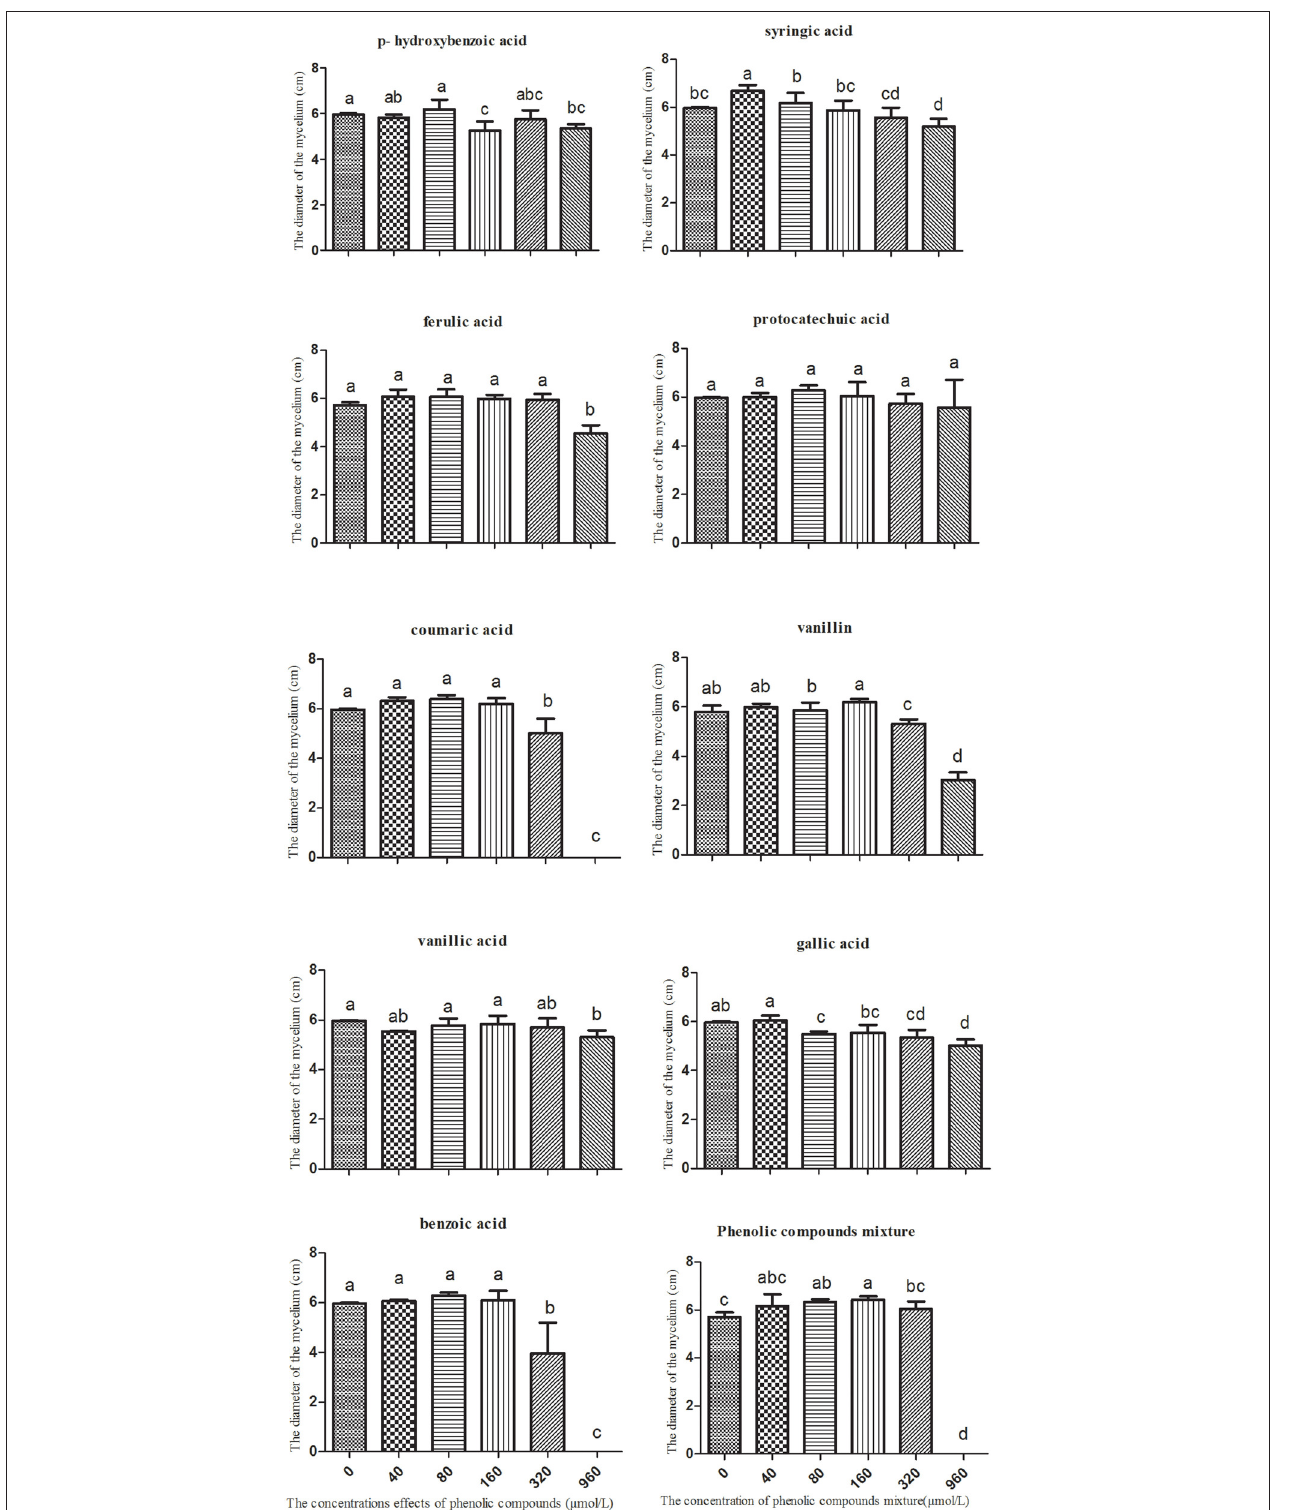
FIGURE 4 | The effects of single phenolic compounds and their mixture on the mycelial growth of Talaromyces helices M. Columns with different letters are statistically different (LSD-test, p < 0.05 ).